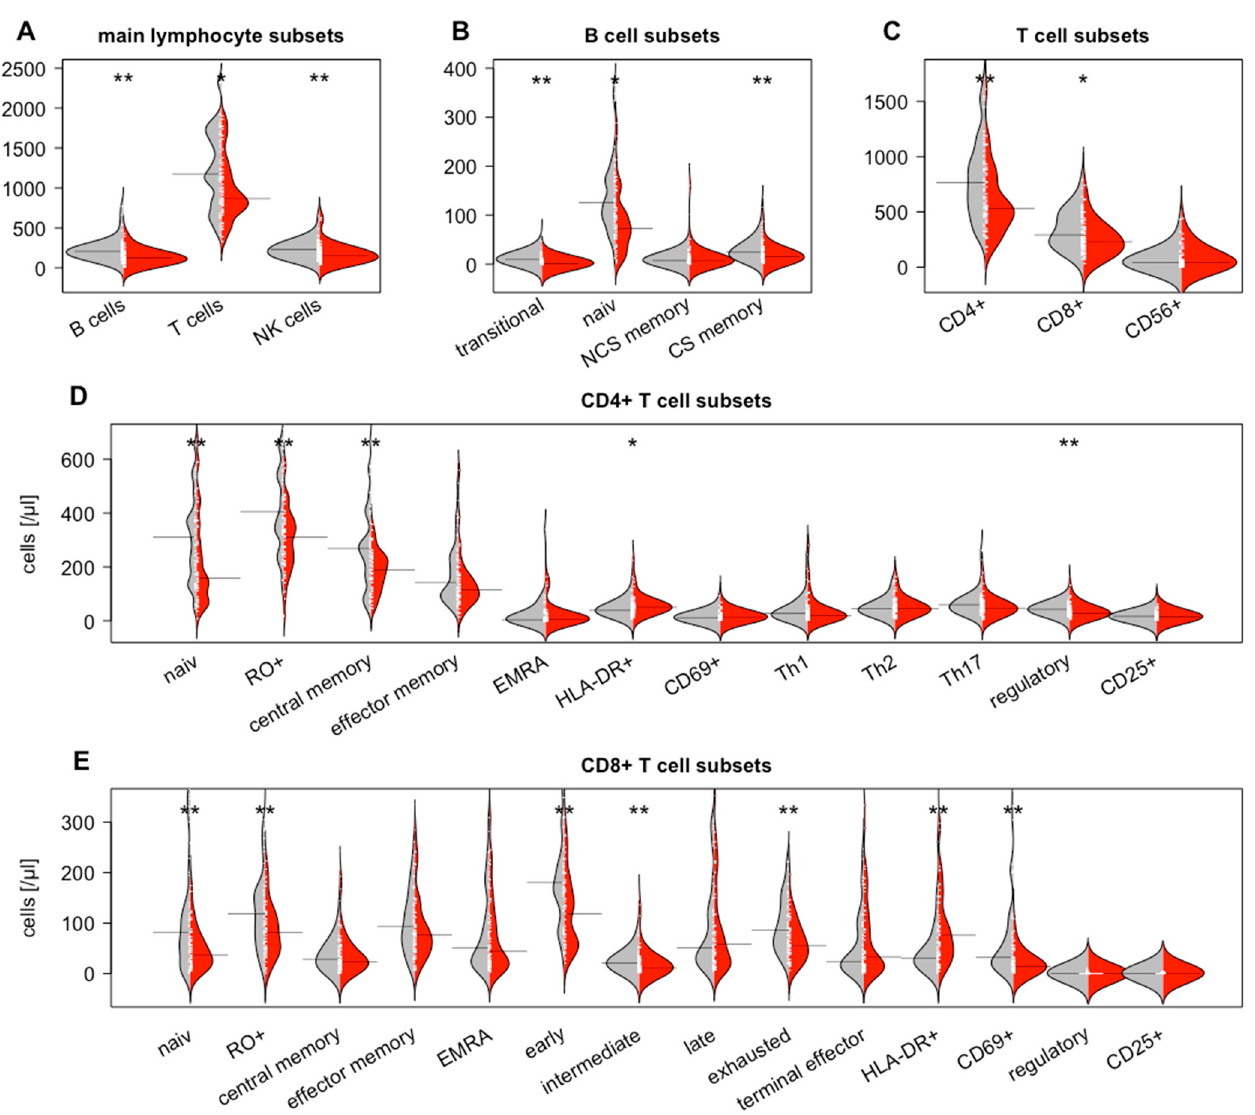
Figure 4. Comparison of the circulating lymphocyte subsets between patients with a low (LN5 very low and MSR0; grey dots) or high (LN5 low and high and MSR1; red dots) lymph node immune activation. ( A ) Main lymphocyte subsets, ( B ) B-cell subsets, ( C ) T-cell subsets, ( D ) CD4+ T-cell subsets, and ( E ) CD8+ T-cell subsets. Significant p -values are marked with * for p < 0.05 and ** for p < 0.005.